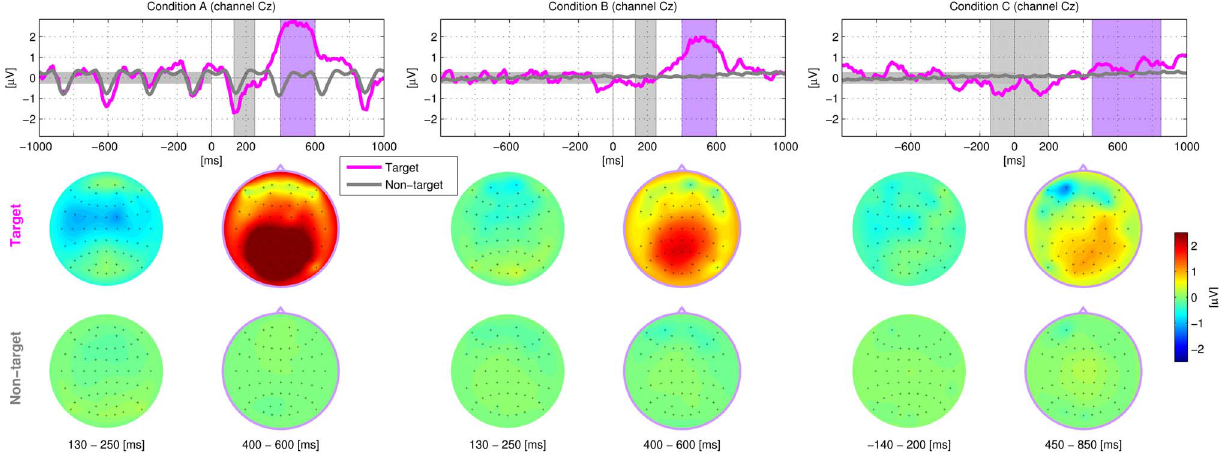
Figure 5. Grand averaged ERPs for conditions A, B and C. It should be noted that the stimulation speed of condition A is slower than in condition B and C.